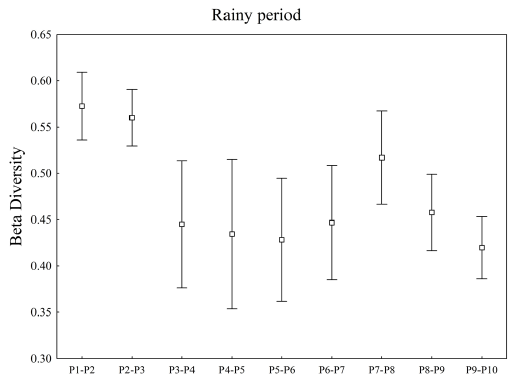
Figure 7. Species variation along the Paraná River during the rainy period. The dots represent the mean values and the bars represent the standard deviations.